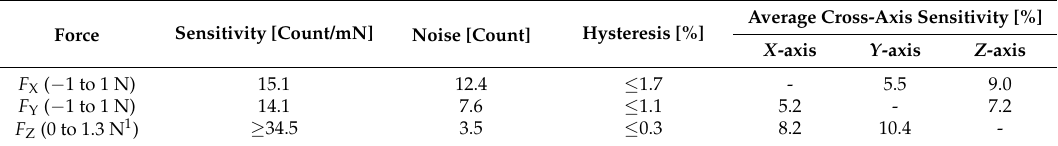
Figure 12. Response of the 3-axis integrated tactile sensor as a function of temperature. Table 1. The performance of the fabricated 3-axis integrated tactile sensor.